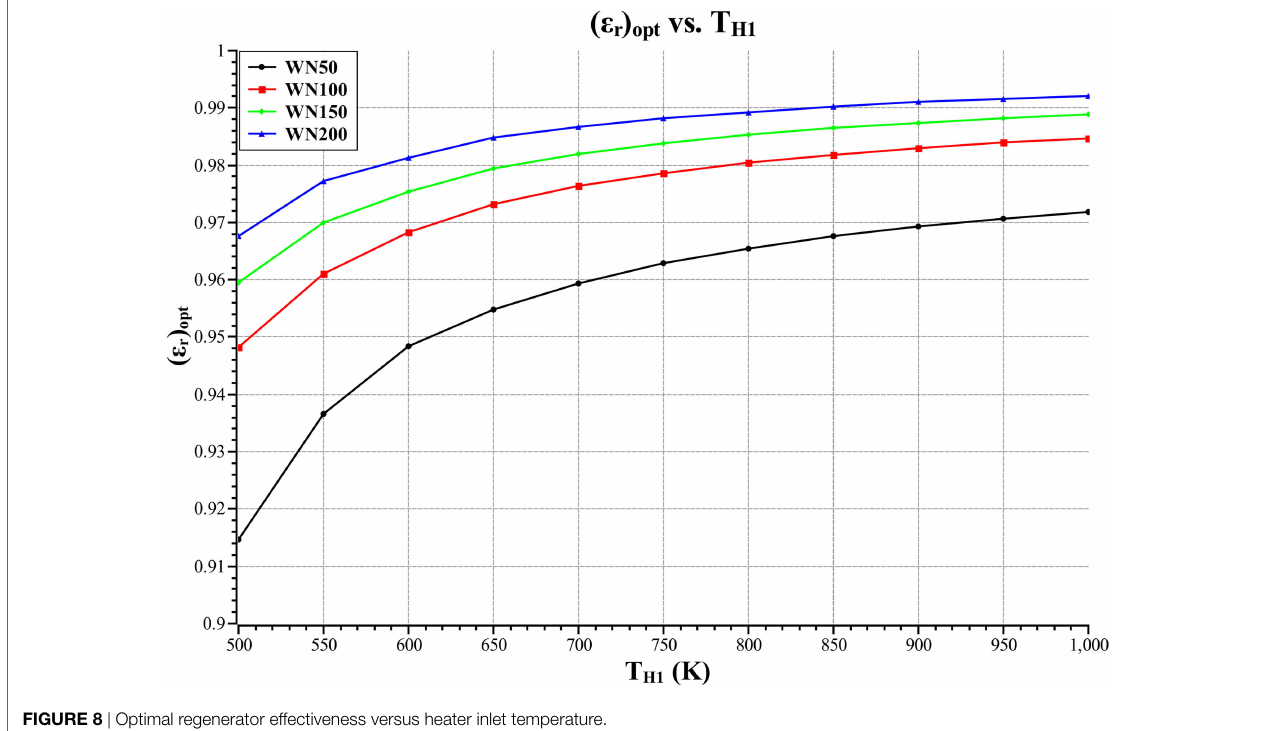
FIGURE 8 | Optimal regenerator effectiveness versus heater inlet temperature.